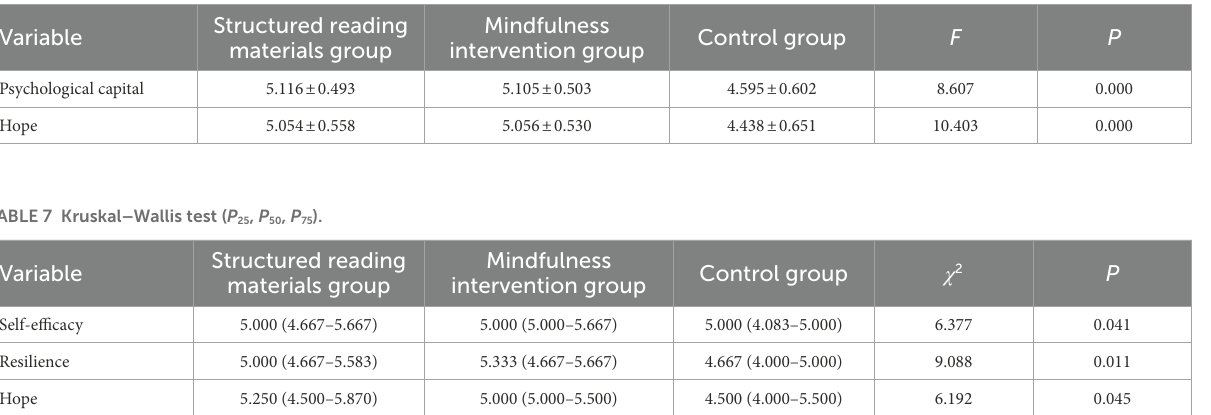
TABLE 6 One-Way ANOVA (